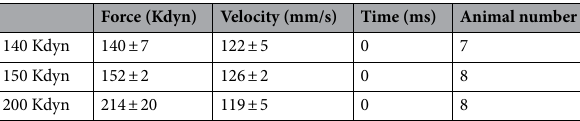
Table 1. Infinite Horizon impact parameters.